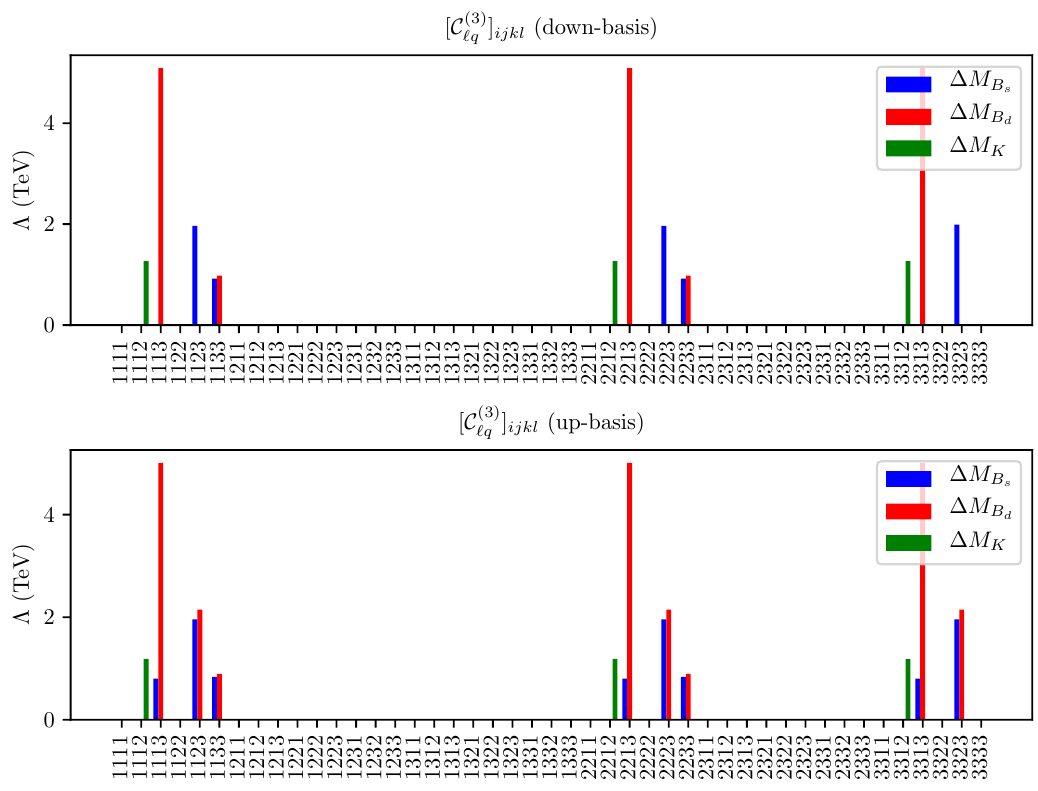
(cid:2) (cid:3) c (3) = 10 that corresponds to a 10% effect in ‘q ijkl